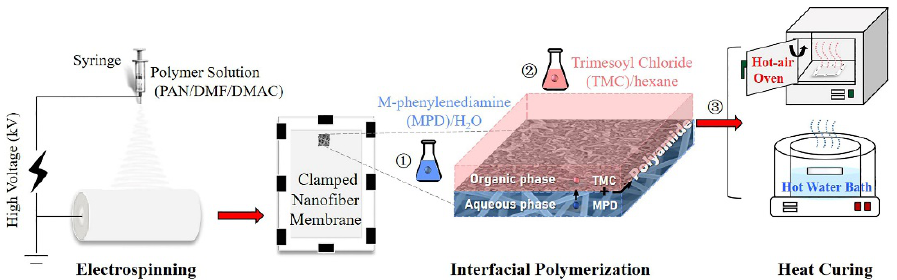
Figure 1. Schematic diagram of the preparation process of nanofiber-supported thin-film composite (TFC) forward osmosis (FO) membranes via different heat-curing methods.